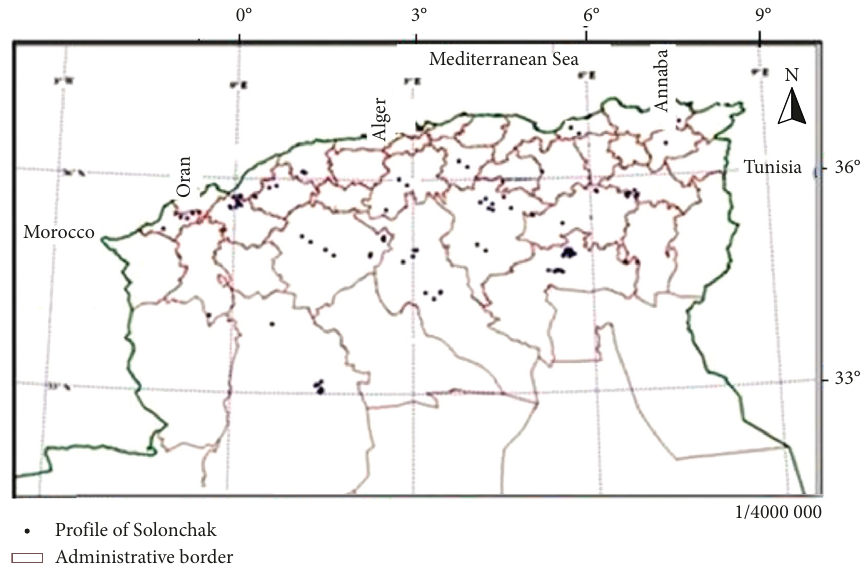
Figure 1: Solonchaks location